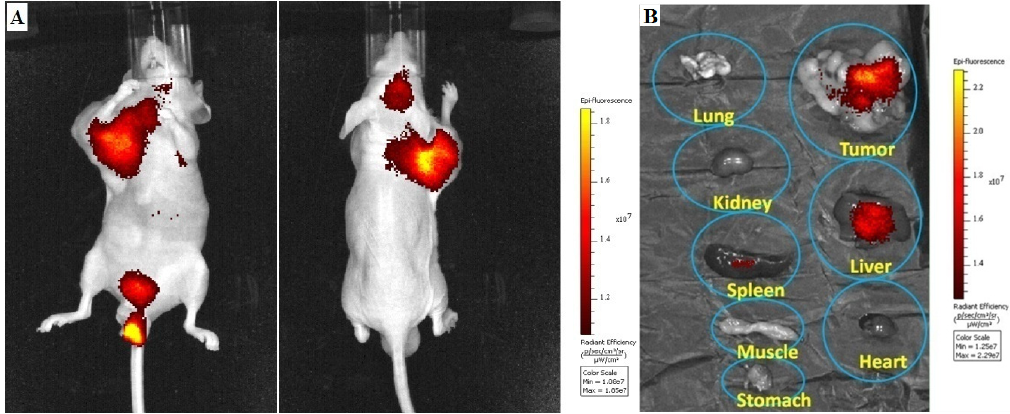
Figure 7. ( A ) Representative NIRF images of A 431 bearing nude mice at 120 h after intravenous injection of 111 In-DG-CCPM. ( B ) Representative NIRF images of various excised tissues from a mouse received 111 In-DG-CCPM at the end of the imaging sessions (120 h